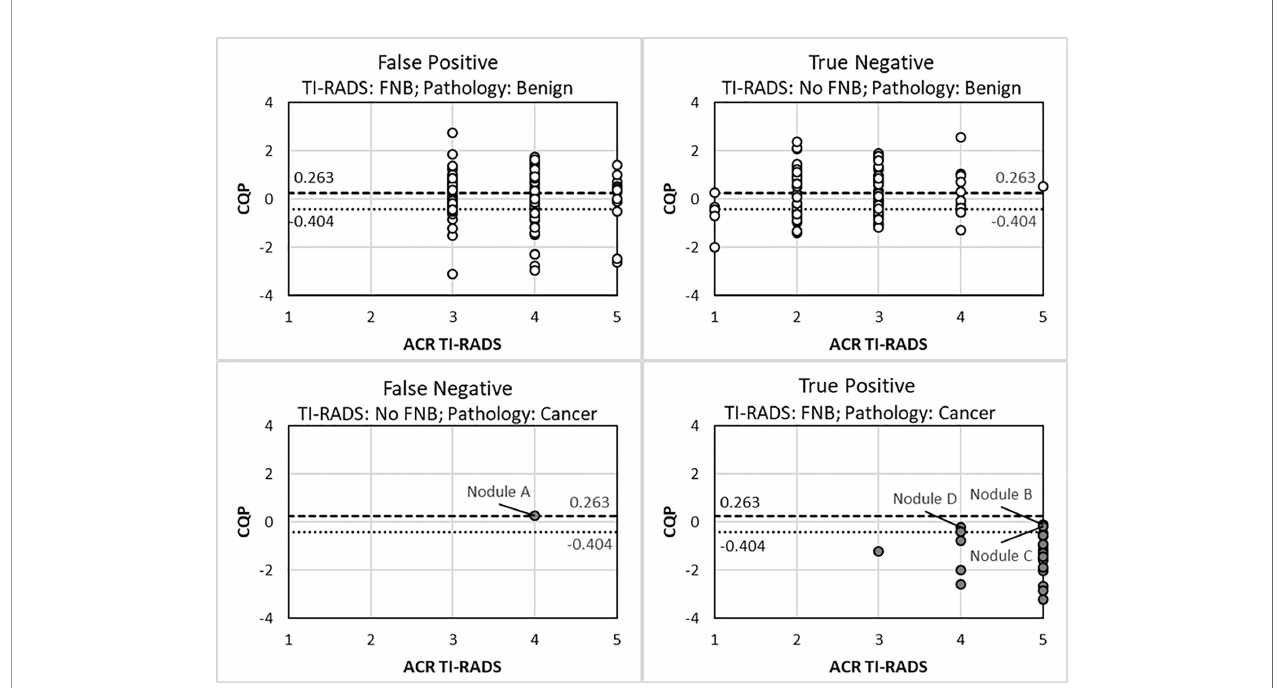
FIGURE 3 | Scatter plot of ACR TI-RADS and combination QUS parameter (CQP) for different FNA decision outcomes. Benign nodule (open circle). Cancer (closed